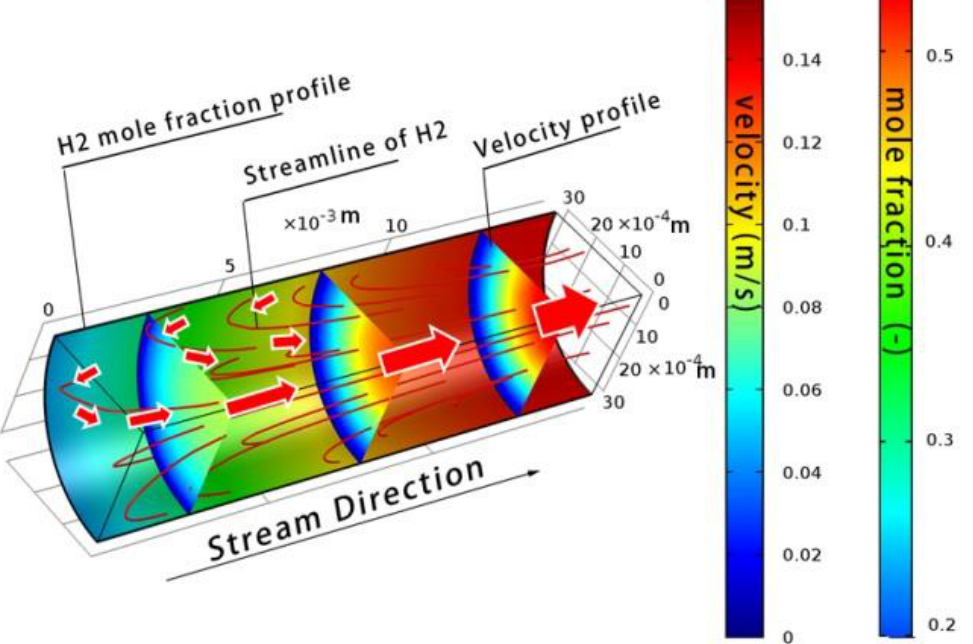
Figure 13. Hydrogen streamline (red lines and red arrows) and velocity field (sectors) in a tube-type channel. (L/D = 5, D = 6 mm, 100,000 mL/g-cat/h).